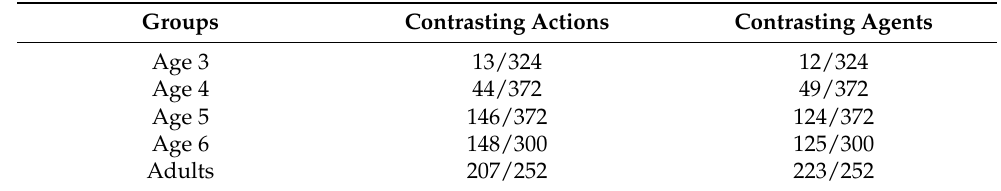
Table A1. Raw scores of PASSIVE RC S produced for contrasting actions and contrasting agent contexts (patient-modifying context only).